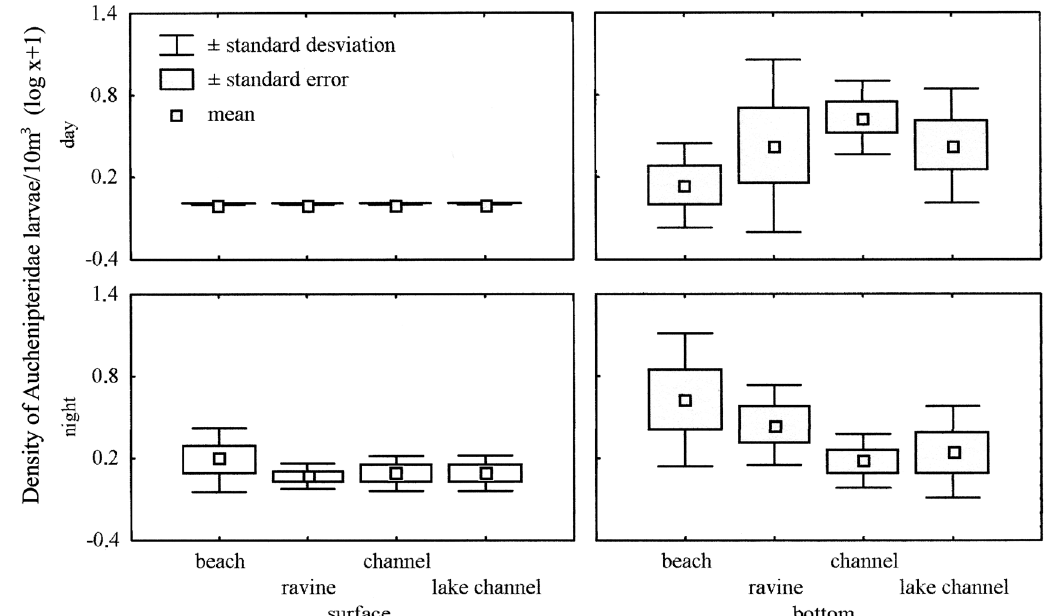
Fig. 5. Abundance of Auchenipteridae larvae in different microhabitats in the surface and bottom in the Anavilhanas Ecologi- cal Station.